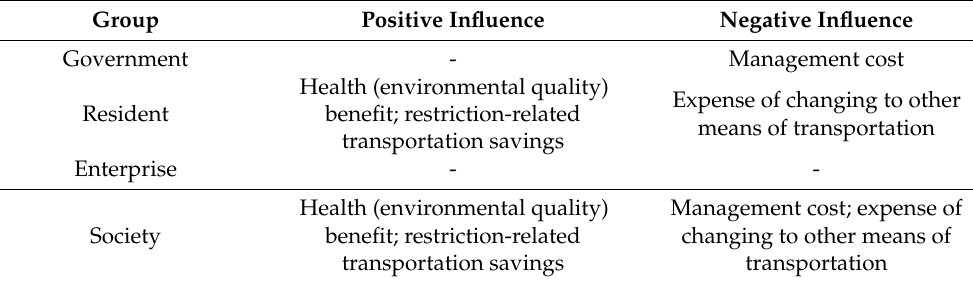
Table 1. Influence matrix of the HEV driving area restriction policy.